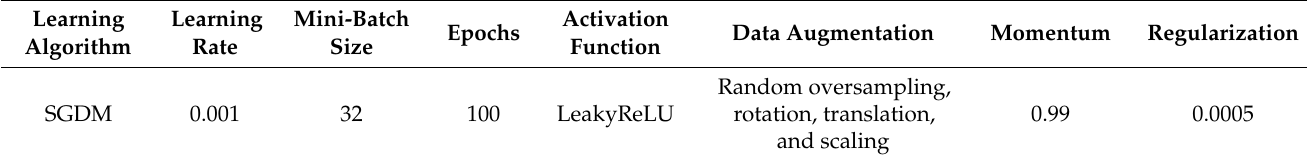
Table 4. Hyperparameter selected for the proposed